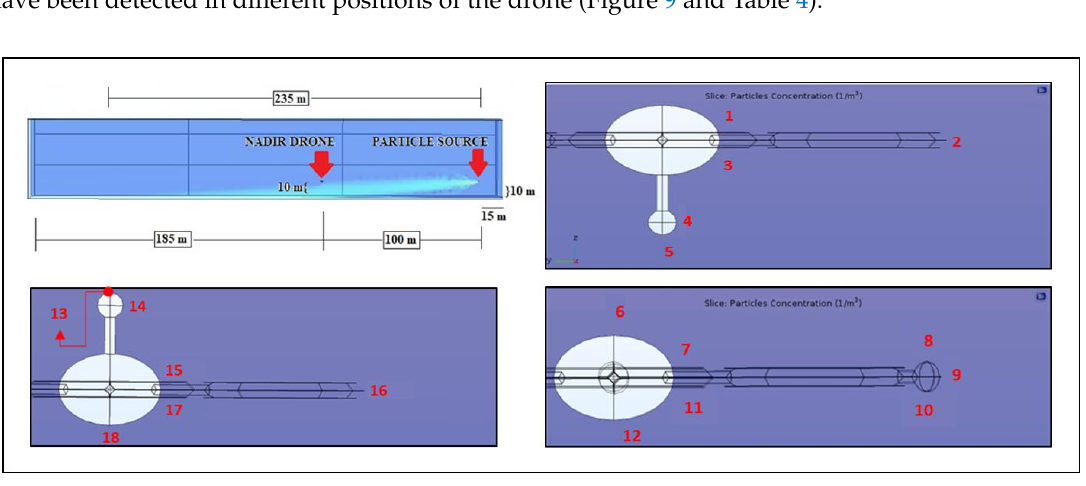
Figure 9. Schematics of the drone-sphere geometry, concentration field, and point analyzed in the numerical set 10-100-10. Table 4. Particle concentration in the reference points of simulation 10-100-10.